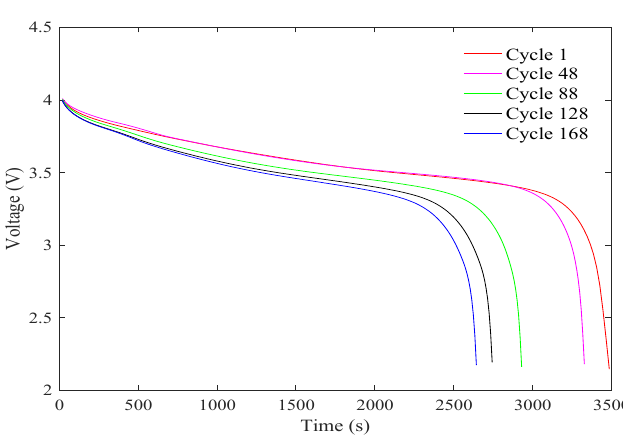
Figure A1. Battery voltage for different discharge cycles.